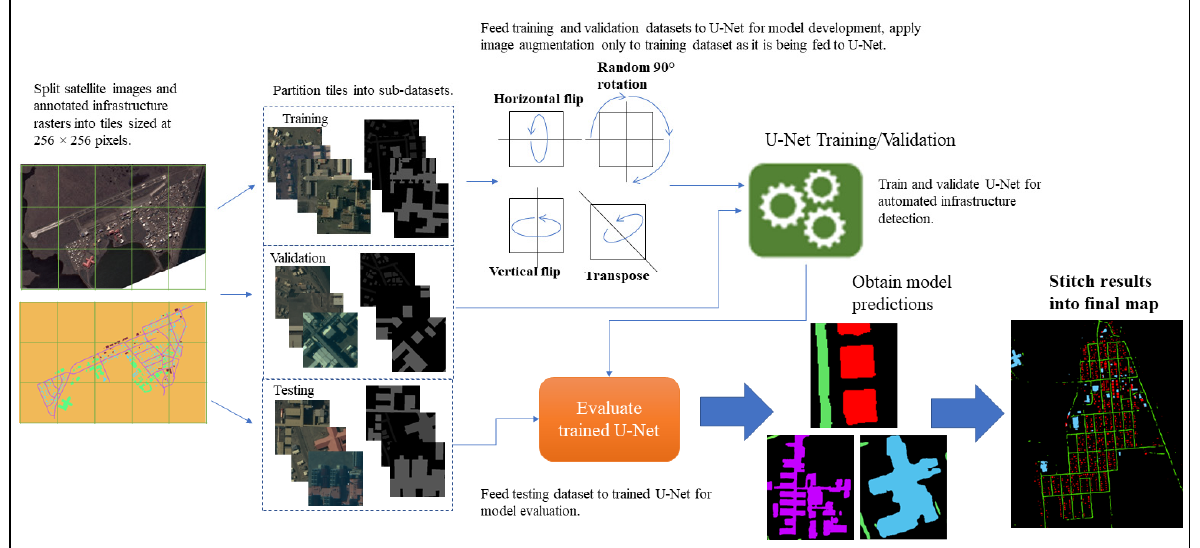
Figure 3. Diagram of generalized automated detection workflow. Imagery © DigitalGlobe, Inc.